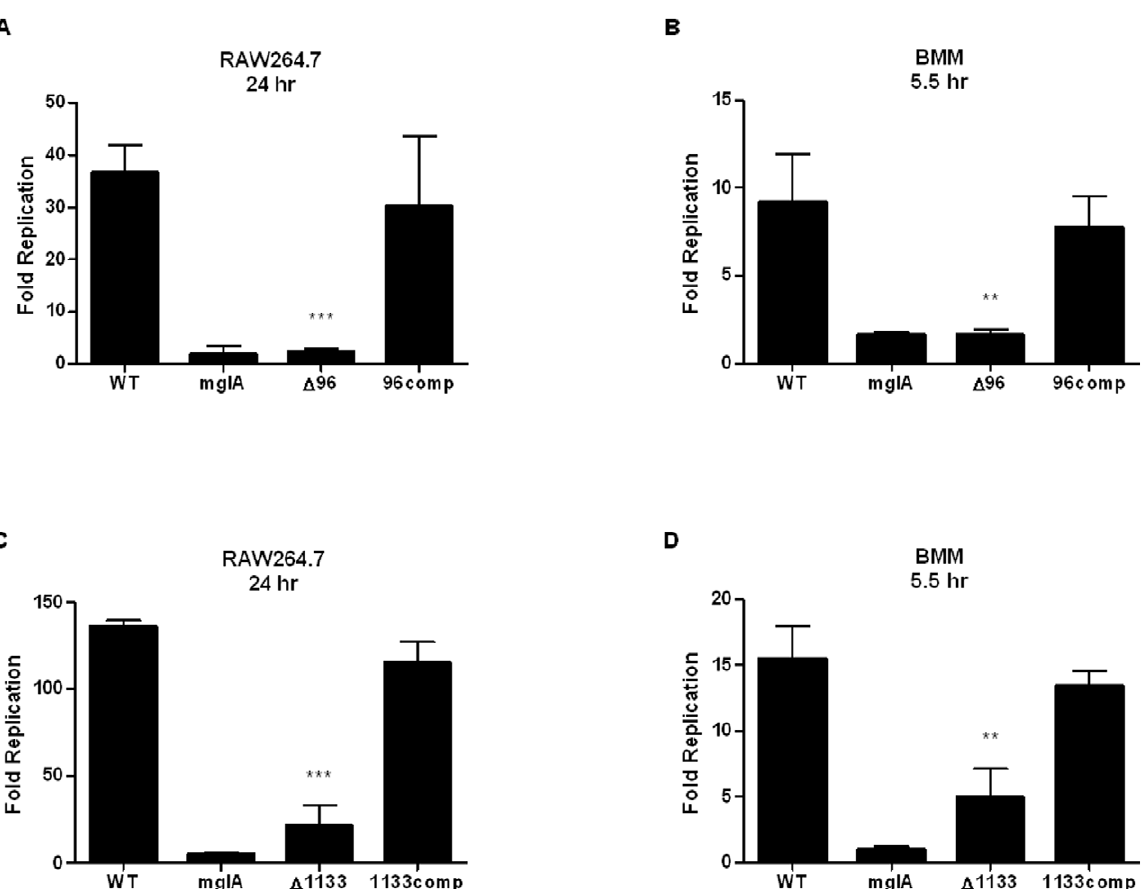
Figure 1. Validation of replication screen results. RAW264.7 macrophages (A and C) or primary murine bone marrow-derived macrophages (BMM) (B and D) were infected with a 20:1 MOI of the indicated bacterial strains. Twenty-four (A and C) or 5.5 (B and D) hours post-infection, fold replication was determined for the FTN_0096 (A and B) and FTN_1133 (C and D) deletion mutants ( D 96 and D 1133) and their respective complemented strains. Wild-type F. novicida and an mglA point mutant strain (GB2) were used as positive and negative replication controls, respectively. For each strain, bars represent the average fold replication and error bars represent the standard deviation (n=3). Data shown is representative of at least three independent experiments. Asterisks indicate significance as compared to wild-type. (**) p , 0.005, (***) p , 0.0005.